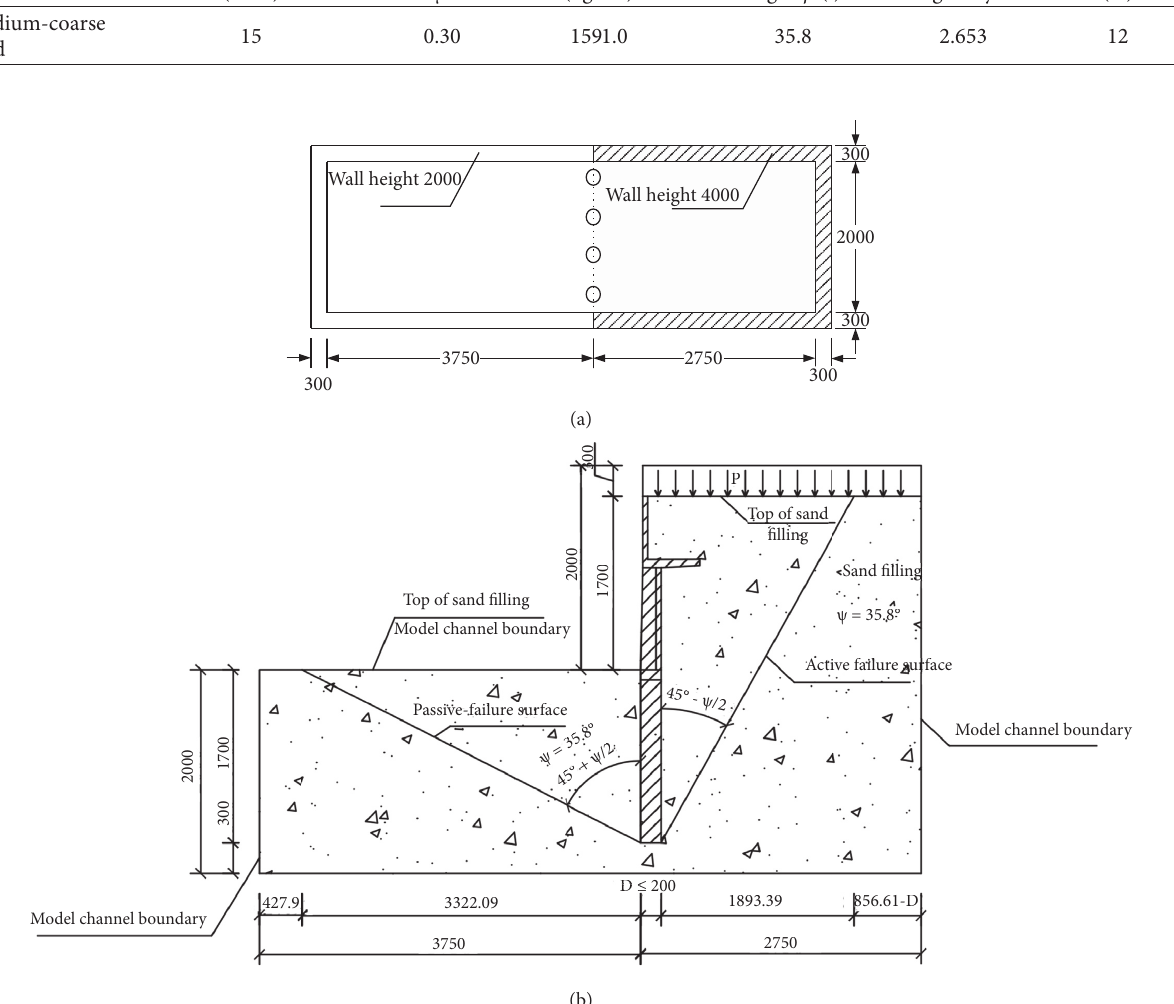
Figure 2: The dimension of the model test box. (a) Planar graph. (b) Profile drawing (the unit of the dimension is mm).